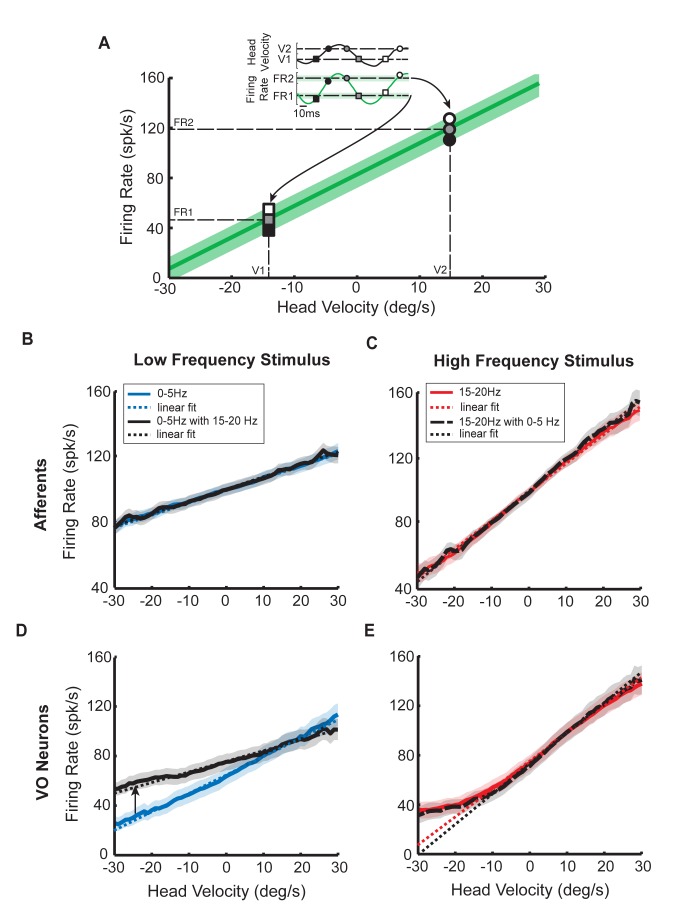
Central vestibular neurons but not afferents display a nonlinear relationship between output firing rate and input head velocity.(A) Output firing rate as a function of head velocity. The inset shows the instantaneous firing rate and the head velocity stimulus as a function of time and the various symbols correspond to different values of the head velocity and the corresponding firing rates. If the firing rate is related linearly to the head velocity stimulus, then the curve relating the two should be well fit by a straight line. The slope of this line is then the response gain. (B) Population-averaged firing rate response as a function of head velocity for afferents when stimulated with 0–5 Hz noise alone (solid blue) and concurrently with 15–20 Hz noise (solid black). In both cases, the curves were well fit by straight lines (dashed lines) and largely overlapped (0–5 Hz alone: R
2 = 0.99, slope = 0.70 (spk/s)/(deg/s), y-intercept = 98 spk/s; 0–5 Hz with 15–20 Hz: R
2 = 0.99, slope = 0.72 (spk/s)/(deg/s), y-intercept = 98 spk/s). (C) Population-averaged firing rate response as a function of head velocity for afferents when stimulated with 15–20 Hz noise alone (solid red) and concurrently with 0–5 Hz noise (long dashed black). Both curves were again well fit by straight lines (short dashed lines) and largely overlapped (15–20 Hz alone: R
2 = 0.99, slope = 1.97 (spk/s)/(deg/s), y-intercept = 102 spk/s; 15–20 Hz with 0–5 Hz: R
2 = 0.99, slope = 2.06 (spk/s)/(deg/s), y-intercept = 102 spk/s). Note, however, the increased slope with respect to panel B. (D) Population-averaged firing rate response as a function of head velocity for central neurons when stimulated with 0–5 Hz noise alone (solid blue) and concurrently with 15–20 Hz noise (solid black). In both cases, the curves were well fit by straight lines (dashed lines) although the solid black curve had a lower slope (i.e., gain) than the solid blue curve (0–5 Hz: R
2 = 0.98, slope = 1.56 (spk/s)/(deg/s), y-intercept = 67 spk/s; 0–5 Hz with 15–20 Hz: R
2 = 0.87, slope = 0.83 (spk/s)/(deg/s), y-intercept = 81 spk/s). (E) Population-averaged firing rate response as a function of head velocity for central neurons when stimulated with 15–20 Hz noise alone (solid red) and concurrently with 0–5 Hz noise (long dashed black). While both curves were similar and largely overlapped, they were not well fit by straight lines (short dashed lines) that underestimated the firing rate for head velocities <−10 deg/s (15–20 Hz: R
2 = 0.64, slope = 2.32 (spk/s)/(deg/s), y-intercept = 79 spk/s; 15–20 Hz with 0–5 Hz: R
2 = 0.27, slope = 2.78 (spk/s)/(deg/s), y-intercept = 79 spk/s). We note that central neurons did not display rectification since the firing rate was always above zero.